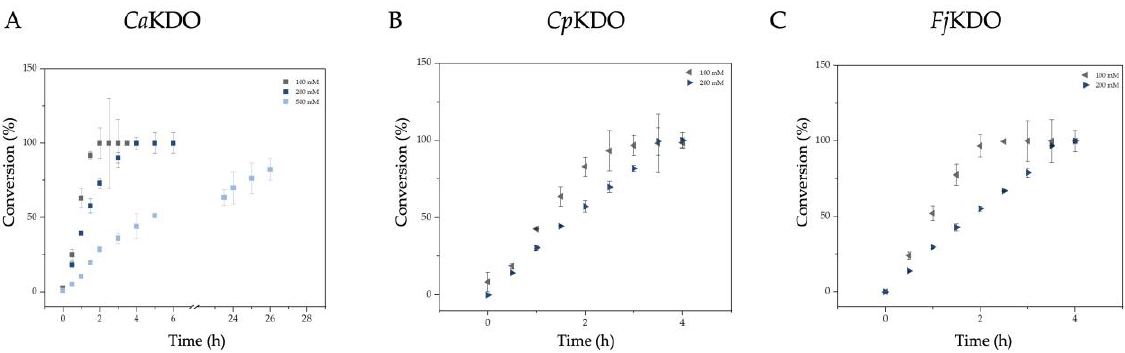
Figure 4. Conversion curves for different L-lysine concentrations (100 mM–500 mM). Reactions were performed in a 1 mL scale in 200 mM HEPES, pH 7.5 with 5 mg mL − 1 Ca KDO ( A ), Cp KDO ( B ), and Fj KDO ( C ) for 100 mM L-lysine and 7.5 mg mL − 1 Ca KDO, 6.5 mg mL − 1 , Cp KDO, 6 mg mL − 1 Fj KDO for 200 mM L-lysine, respectively. Conversions with 500 mM L-lysine were performed with 5 mg mL − 1 immobilized Ca KDO. The reaction mix contained 100–500 mM L-lysine, 150–750 mM α -KG (1.5 fold excess), 2.5 mM L-ascorbic acid, 0.01 mM DTT, and 1 mM (NH 4 ) 2 Fe(SO 4 ) 2 . The reaction was run for 4–26 h at 25 ◦ C in an overhead shaker. Error bars are the result of two independent immobilizations.